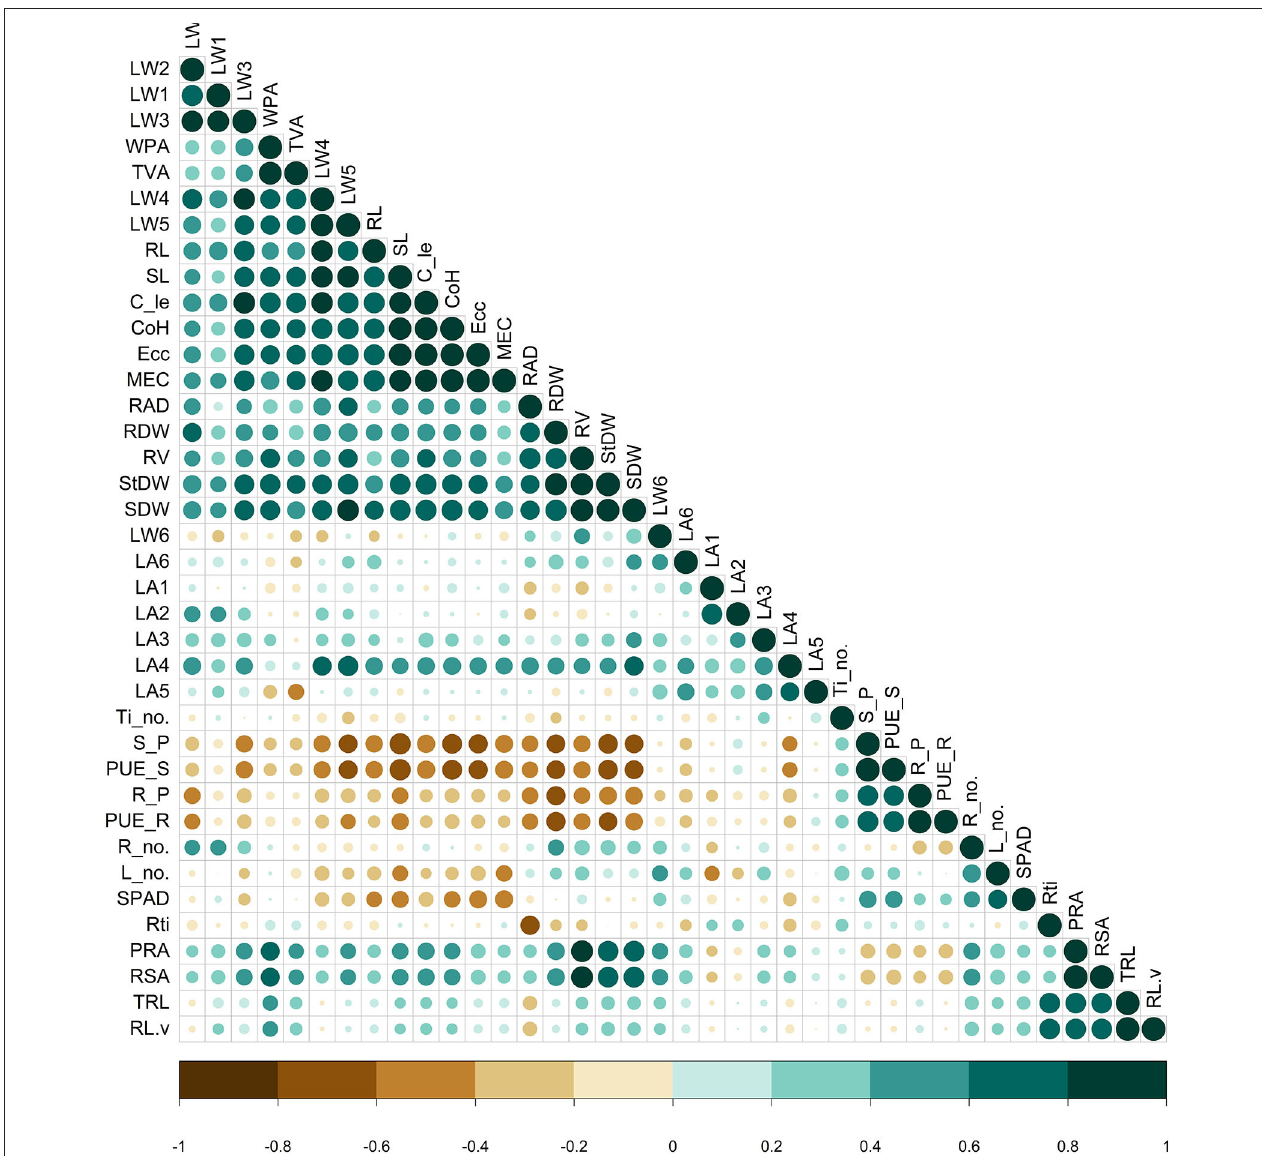
FIGURE 2 | Pearson correlation matrix of the measured traits in the phosphorus (P) stress environment. Colour (green-positive correlation; brown-negative correlation) intensity and the size of circle are proportional to the correlation coefficient. RAD, average root diameter; RDW, root dry weight; RV, root volume; StDW, stem dry weight; SDW, shoot dry weight; LW, leaf weight; WPA, whole plant area; TVA, top view area; RL, maximum root length; SL, shoot length; C_le, calliper length; CoH, convex hull; Ecc, eccentricity; MEC, minimum enclosing circle; LA, leaf angle; Ti_no, tiller number; S-P- shoot P content; PUE_S, PUE of the shoot; R_P, root P content; PUE_R, PUE of the root, Rti, root tip; TRL, total root length; PRA, projected root area; RSA, root surface area; R_no.- number of roots, L_no., leaf